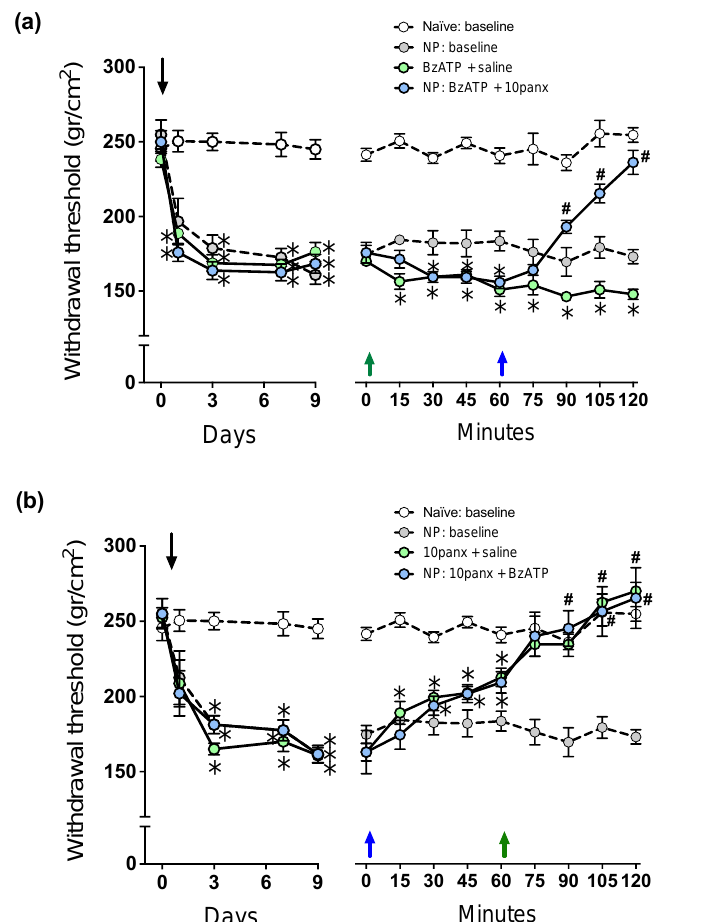
Figure 3. Effect of intrathecal administration of BzATP followed by 10panx, or 10panx followed by BzATP, on the mechanical nociceptive threshold (in g/cm 2 ) of neuropathic (NP) rats. Naïve (baseline) and NP (baseline) rats without receiving any drug served as controls. Values are means ± SEM, n = 6 rats in each group. ( a ) Left panel: Time course of development of NP after sural nerve cutting, performed on day zero (downward arrow), during a 9-day period of follow-up. Two-way repeated measures ANOVA revealed a “time” effect (F 2.992,59.84 = 65.12). Intragroup analysis: * p at least <0.05 in NP rats with respect to the threshold prior to sural nerve cutting, Bonferroni multiple compari- sons test. Right panel: Time course of changes in mechanical nociceptive threshold after a 10 µL injection of saline i.t. or 150 µM BzATP i.t. on day 10 at time zero min (green upward arrow), fol- lowed by saline i.t. or 300 µM 10panx i.t. at time 60 min (blue upward arrow). Two-way repeated measures ANOVA revealed a “time” effect (F 5.628,112.6 = 8.096). Intragroup analysis: * p at least <0.05 with respect to time zero min, # p at least <0.05 with respect to time 60 min, Bonferroni multiple comparisons test). Note the hyperalgesic effect of NMDA, and the counteracting effect of 10panx. ( b ) Left panel: Time course of development of NP after sural nerve cutting, performed on day zero (downward arrow), during a 9-day period of follow-up. Two-way repeated measures ANOVA re- vealed a “time” effect (F 2.112, 42.24 = 50.46). Intragroup analysis: * p at least <0.05 in NP rats with respect to the threshold prior to sural nerve cutting, Bonferroni multiple comparisons test. Right panel: Time course of changes in the mechanical nociceptive threshold of NP rats on an inverse scheme of drug administration: a 10 µL injection of saline i.t. or 300 µM 10panx i.t. was administered at time zero min (blue arrow), and saline i.t. or 150 µM BzATP i.t. one hour later, at time 60 min (green arrow). Two- way repeated measures ANOVA revealed a “time” effect (F 5.437,108.7 = 53.94). Intragroup analysis: * p at least <0.05 with respect to time zero min, # p at least <0.05 with respect to time 60 min, Bonferroni multiple comparisons test). Note the antihyperalgesic effect of 10panx, and its prevent- ing effect on the ability of BzATP to induce hyperalgesia.